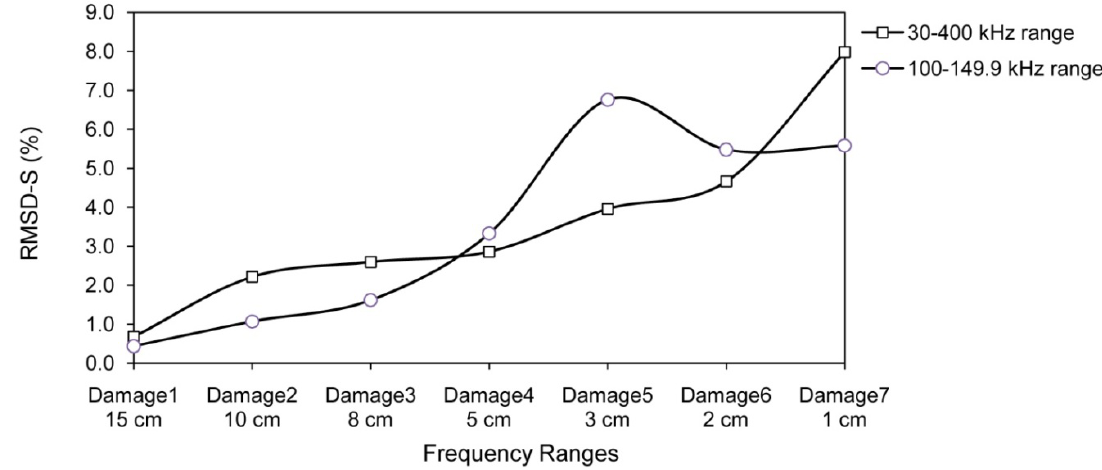
Figure 15. Inconsistency in EMI result for RMSD of limited frequency